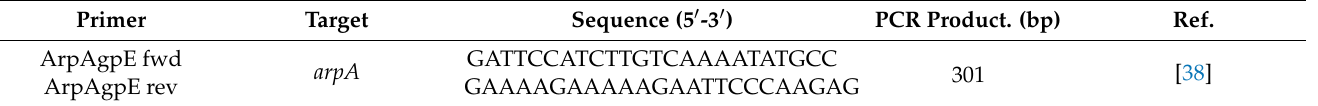
Table 10. List of primers used for the distinction of phylogroups E or D, or E or I